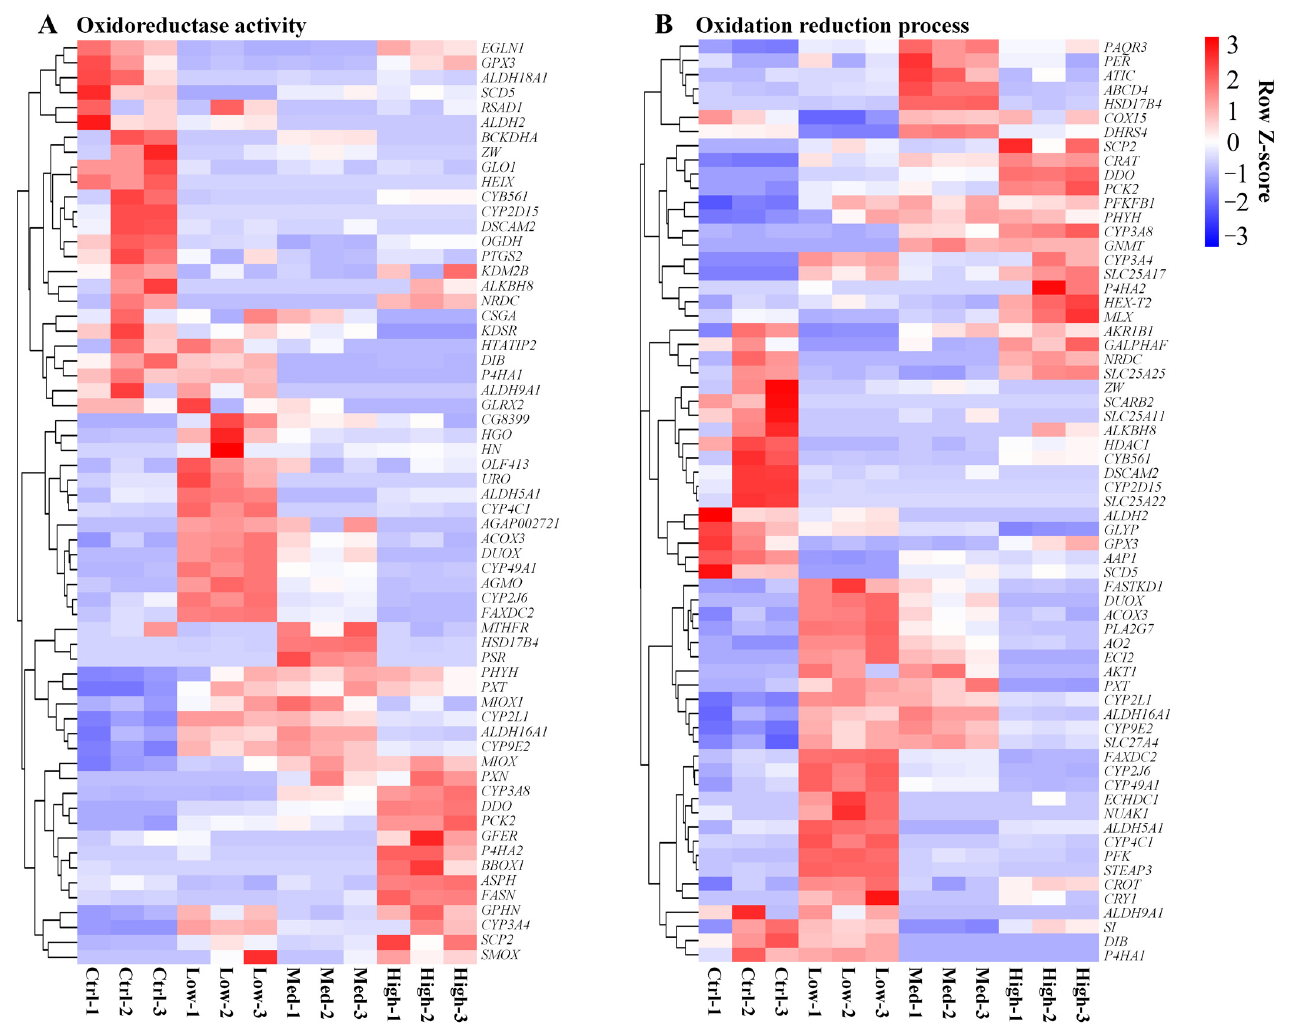
Figure 5. The effects of treatment with different concentrations of Hg on redox metabolism-related gene expression. Terms linked to redox metabolism, such as oxidoreductase activity ( A ) and oxidation-reduction process ( B ). Each gene was assessed based on its average FPKM value. The genes with higher expression levels are colored red and those with lower expression levels are colored blue. Ctrl: 0 μ g/L Hg 2+ ; Low: 8.75 μ g/L Hg 2+ ; Med: 21.875 μ g/L Hg 2+ ; High: 43.75 μ g/L Hg 2+ .